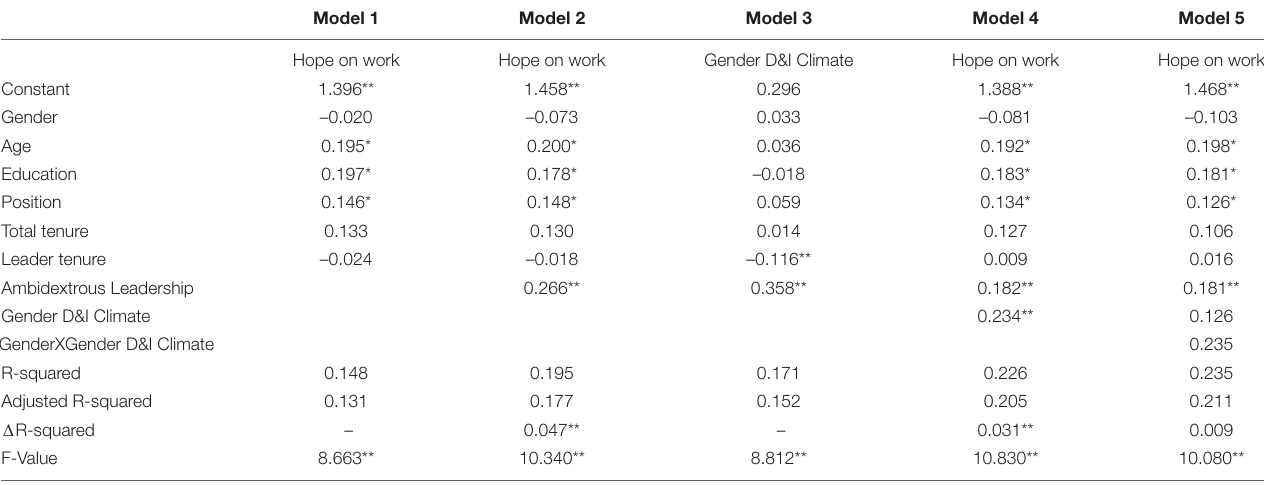
TABLE 2 | Regression analysis among the variables, female ambidextrous leadership, gender D&I climate, and hope on work ( N =